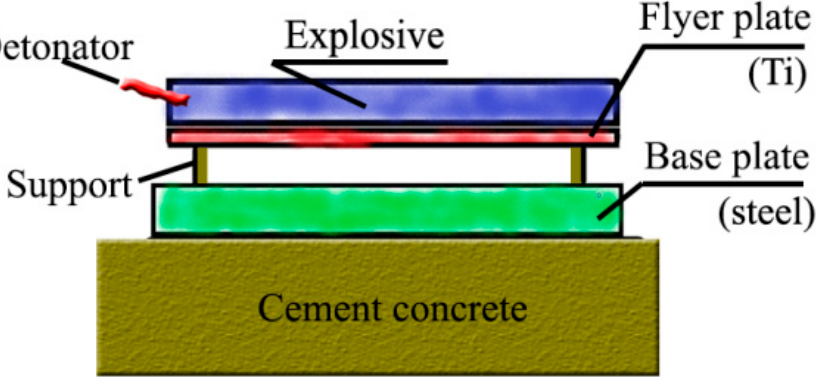
Figure 1. Schematic illustration of the process of explosive welding. Table 1. The chemical composition (wt%) of the TA1.